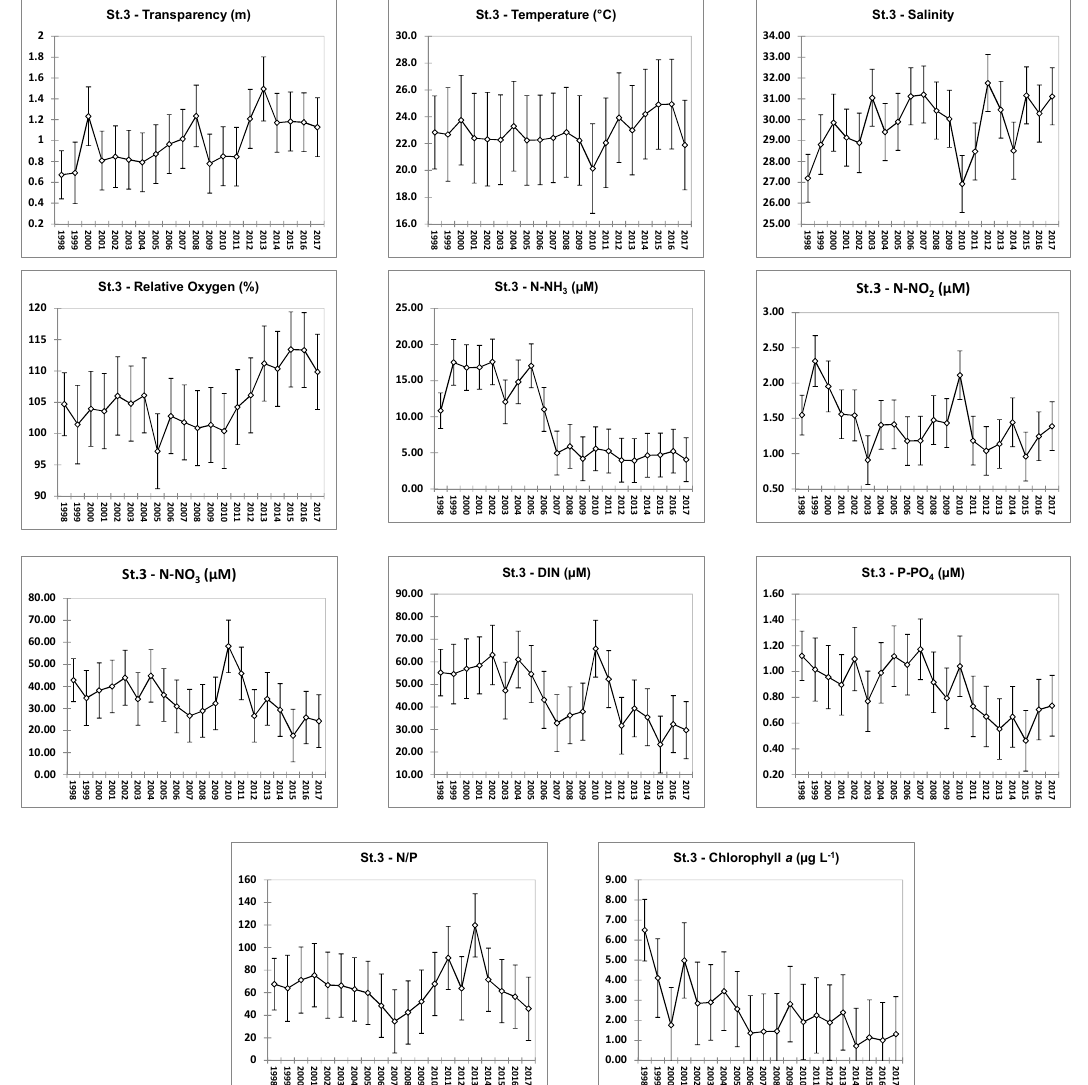
Figure 3. Yearly averages and confidence limits for hydrochemical parameters at St.3. Lower and upper bounds of means (95%) are shown.